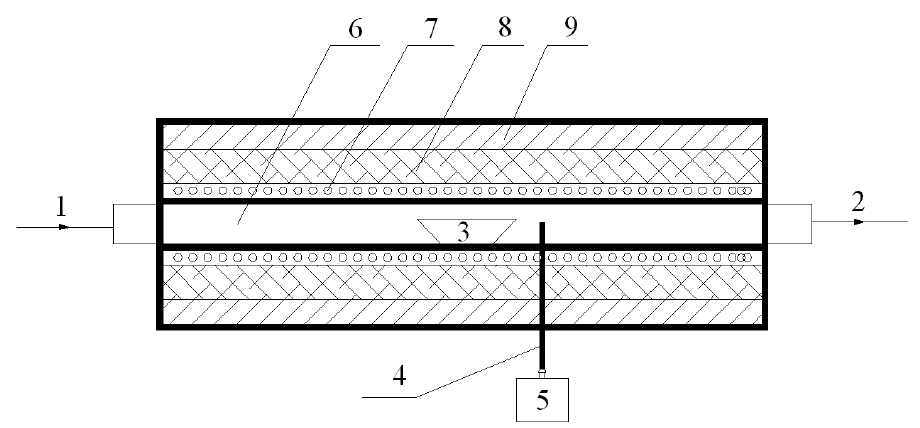
Figure 2. Schematic diagram of the high-temperature tube furnace. 1. air inlet; 2. air outlet; 3. sample holder (crucible); 4. thermocouple; 5. temperature control system; 6. tube reactor; 7. heating element; 8. refractory; 9. insulation.